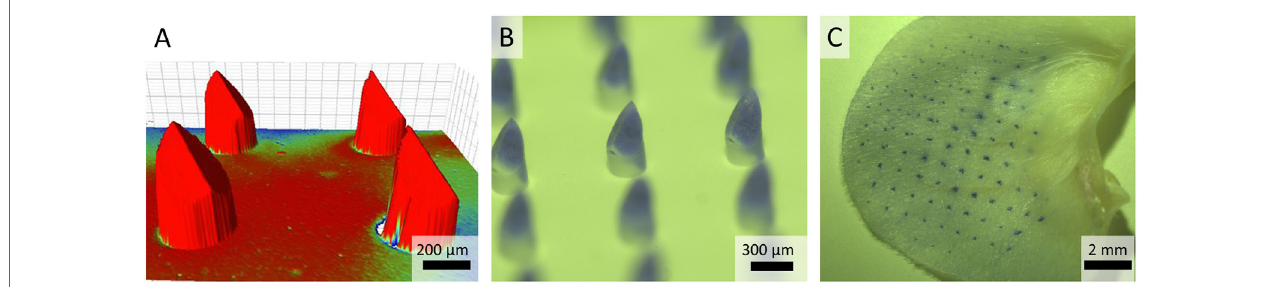
FigUre 2 | (a) Bruker analysis was used for geometry and surface analysis and to measure the distance between the microneedle backplate and microneedle tip. The color is indicative for the size of the substrate-fillable microneedles. (B) Brightfield microscopy images of a nanoporous microneedle array (npMNA) of which only the microneedle tips are loaded with a trypan blue solution. (c) Representative image of a trypan blue piercing assay of ex vivo murine ears with an npMNA using the uPRAX